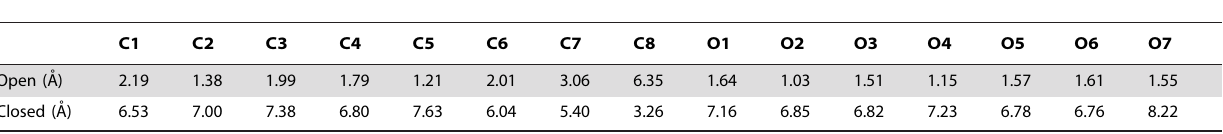
Table 1. RMSDs between the average protein conformations from the unrestrained simulations and the AdK crystal